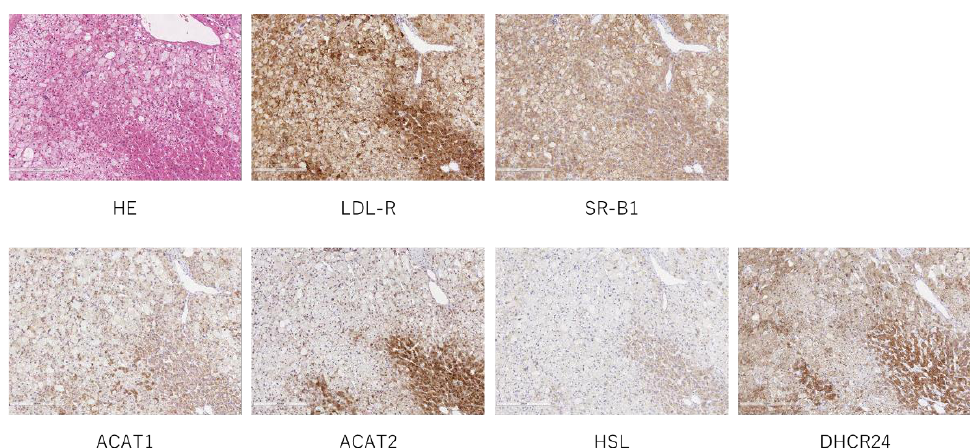
Figure 1. Representative image of H&E staining and IHC. H&E staining and IHC of LDL-R, SR-B1, ACAT1, ACAT2, HSL and DHCR24. Table 1. Comparison of immunoreactivities of receptors and enzymes between clear cells and compact cells. Immunoreactivity of LDL-R, SR-B1, ACAT1, ACAT2, HSL and DHCR24 in both clear and compact tumor cells was semi-quantified and evaluated. Except for LDL-R, immunoreactivity of all the receptor and enzymes examined in this study were higher in compact than in clear tumor cells. The values of each factor were represented by the median [Range: 1st quartile, 3rd quartile].